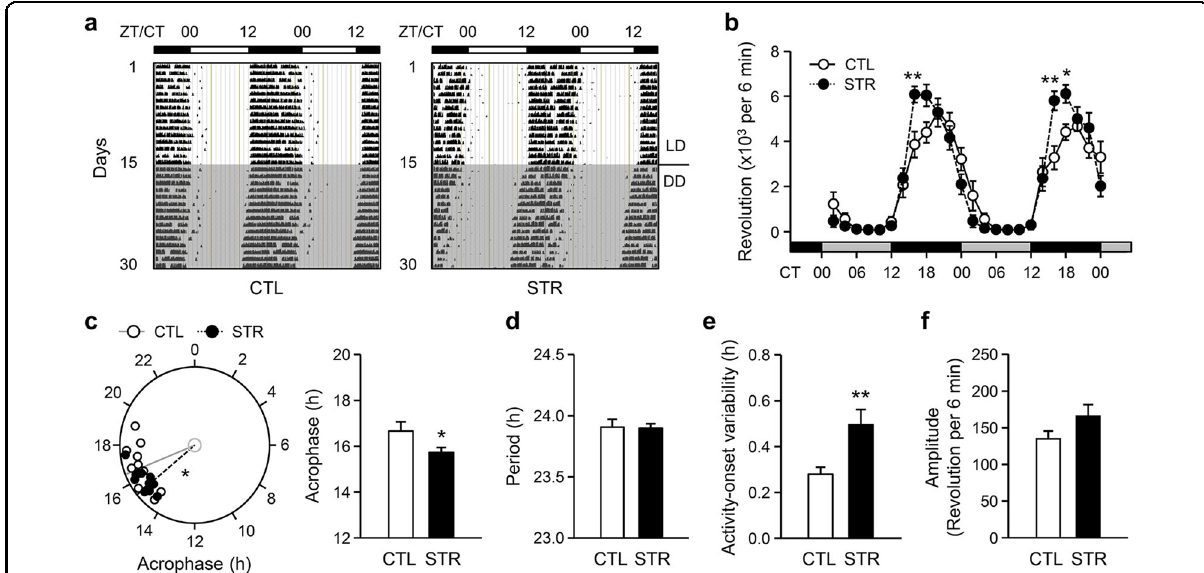
Fig. 4 Altered behavioral rhythms in maternally stressed adult male mice. a Representative double-plotted actograms of the wheel-running activity of CTL and STR mice. b Mean wheel-running activity on the 4th and 5th days of DD conditions at 2-h intervals ( n = 12 for each group; * p < 0.05 and ** p < 0.01 between groups by Bonferroni post hoc comparison). c Phase angles of the wheel-running rhythm of each mouse (left) and the acrophase (right) are expressed as the mean ± SE for CTL and STR mice. d – f Period length ( d ), activity onset variability ( e ), and amplitude ( f ) of the circadian wheel-running activity of CTL and STR mice under DD conditions for 10 days from the 4th day after lights were turned off. The data in the bar charts are presented as the mean ± SE in the indicated units ( n = 12 for each group; * p < 0.05 and ** p < 0 . 01 between groups by Student ’ s t